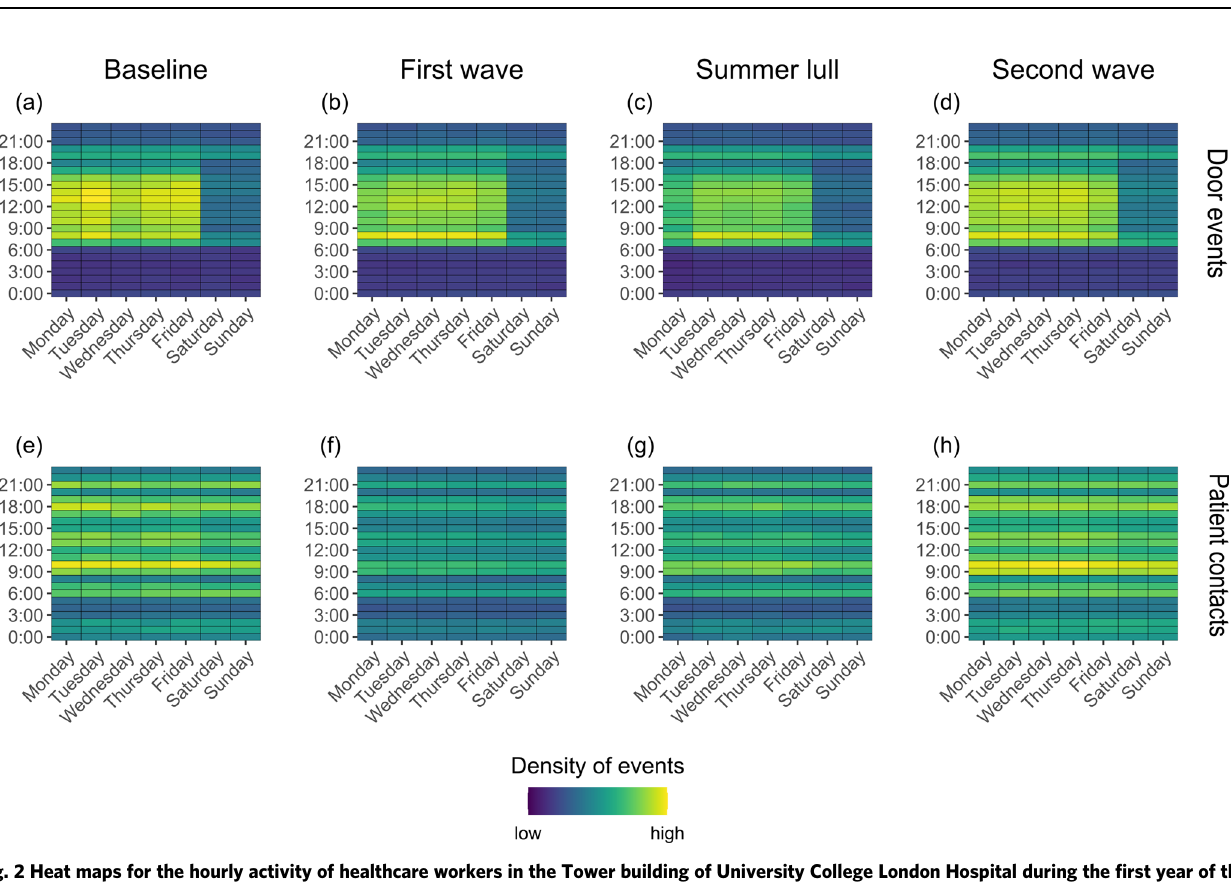
For each stage of the pandemic (pre-pandemic baseline, fi rst wave, summer lull and second wave), the number of observation days is reported along with the total number of healthcare workers, patients, patients positive for COVID-19 (COVID-19 + ), door events, patient contacts, and contacts with COVID-19 + patients. For counts involving COVID-19 + patients, the percentage of all patients/ contacts are provided in brackets.